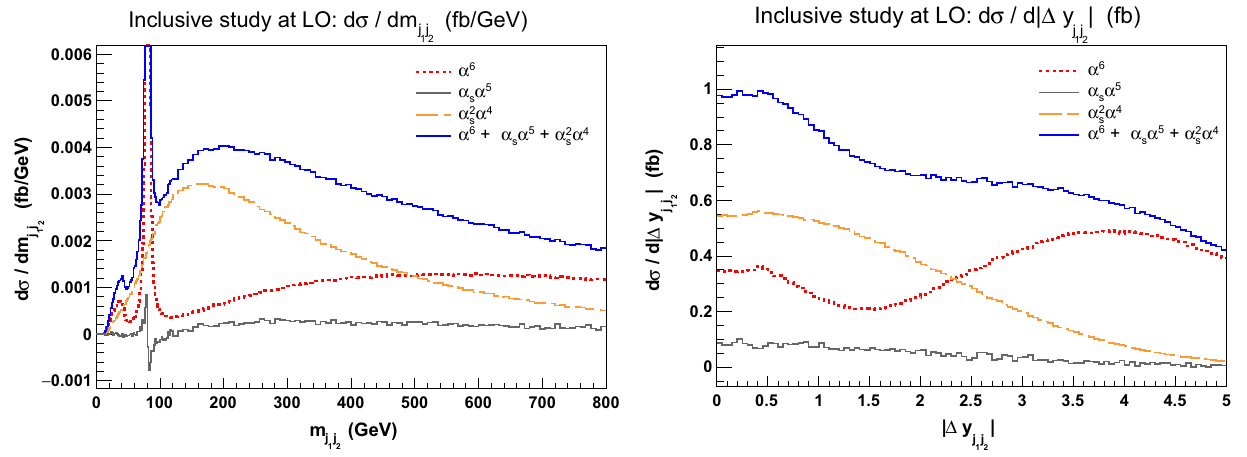
Fig. 2 Differential distribution in the di-jet invariant mass m jj (left) and the difference of the jet rapidities | Δ y jj | (right) for the three LO contributions to the process pp → μ + ν μ e + ν e jj. The EW contribution